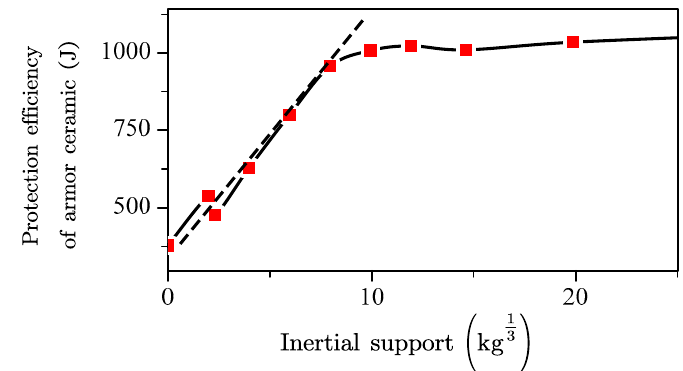
Figure 9. Effect of the inertia support on the protection efficiency of the armor